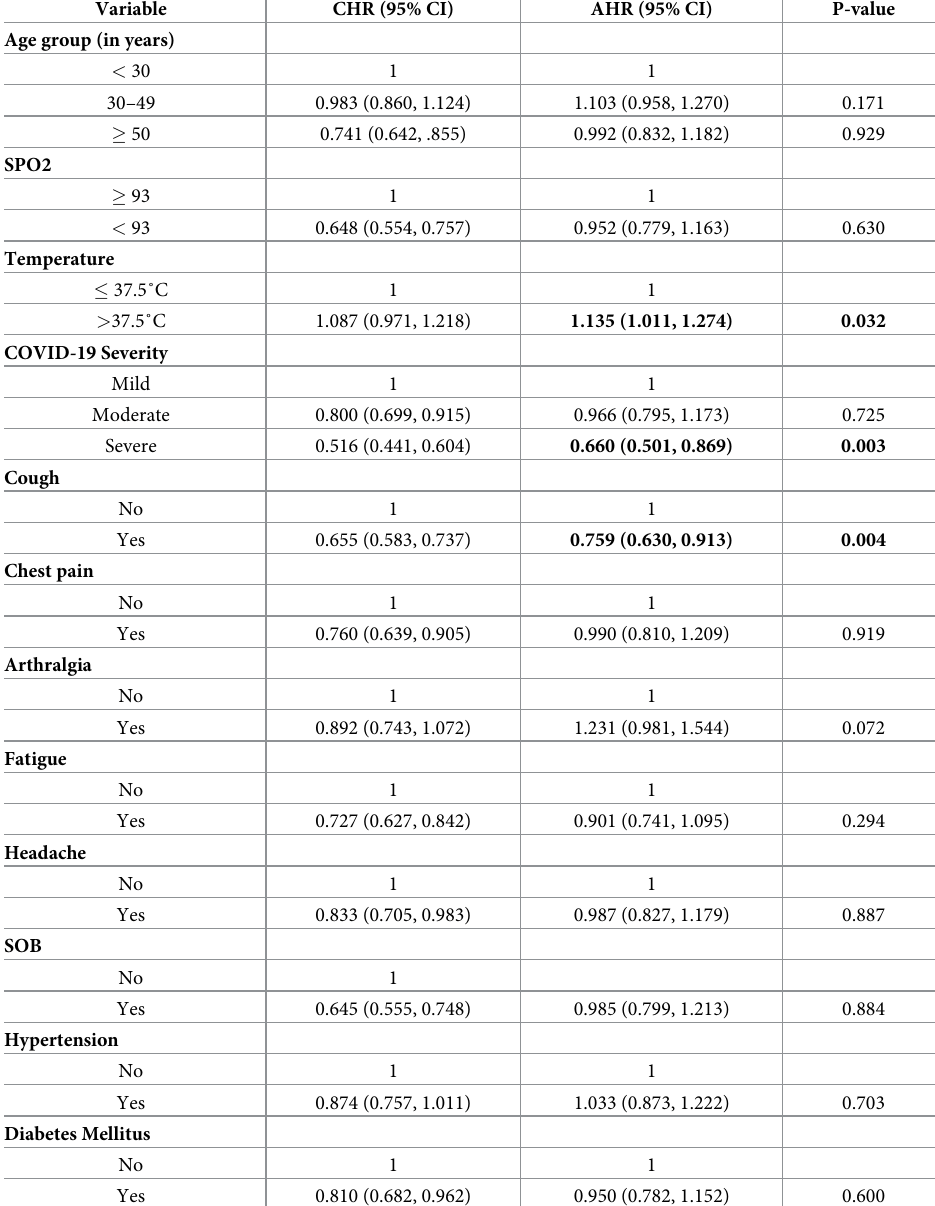
Table 2. Result of multivariable Cox proportional hazard model among patients with COVID-19 (n =